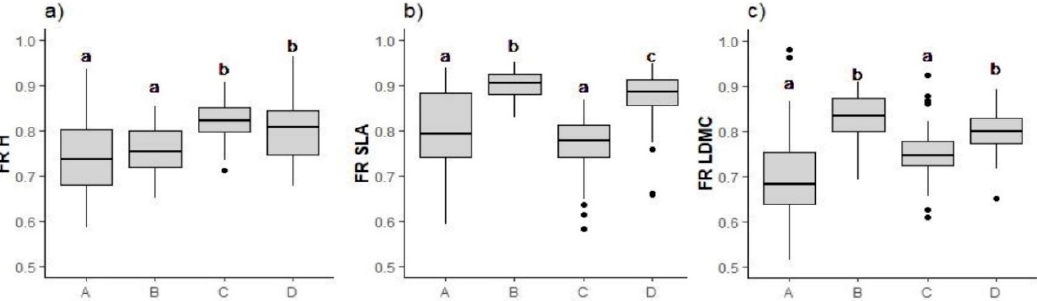
Figure 2. Boxplots comparing functional redundancy values (FR) of the analyzed plant communities (A: Leucopoa dimorpha community, B: Sesleria juncifolia community, C: Plantago atrata community, D: Silene acaulis community) for: ( a ) plant height (FR H ), ( b ) specific leaf area (FR SLA ) and ( c ) leaf dry matter content (FR LDMC ). Boxplots with different letters indicate statistically significant differences (Tukey’s post hoc test; p < 0.05).